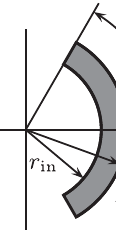
FIG. 3. Sketch of a sector coil generating an approximate dipole field.